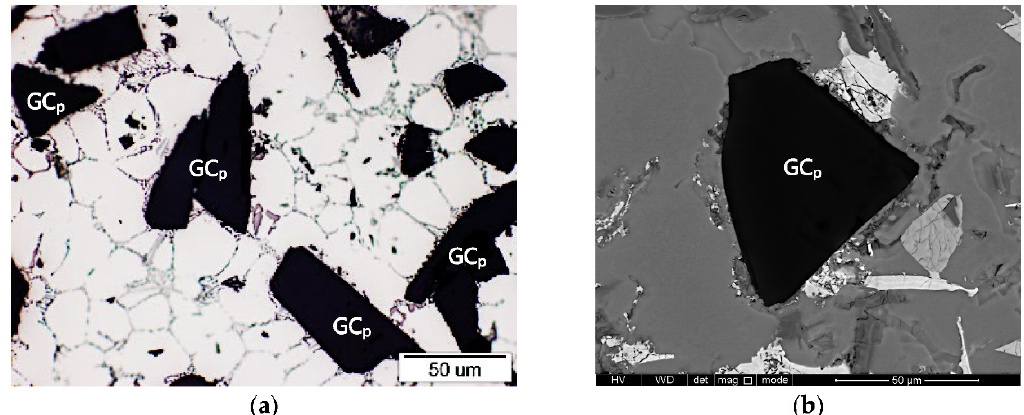
Figure 18. Microstructure of AlSi12/GC p composite: ( a ,) LM; ( b )